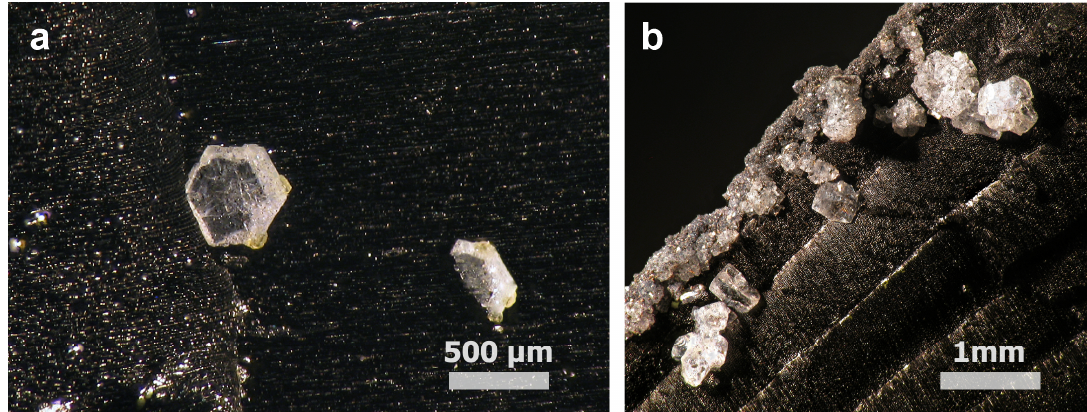
Figure 1. The crystals of CaAl 2 Si 2 O 8 polymorphs on the surface of charcoal: ( a ) hexagonal plates of dmisteinbergite; ( b ) dmisteinbergite in association with prismatic anorthite crystals. Photography by